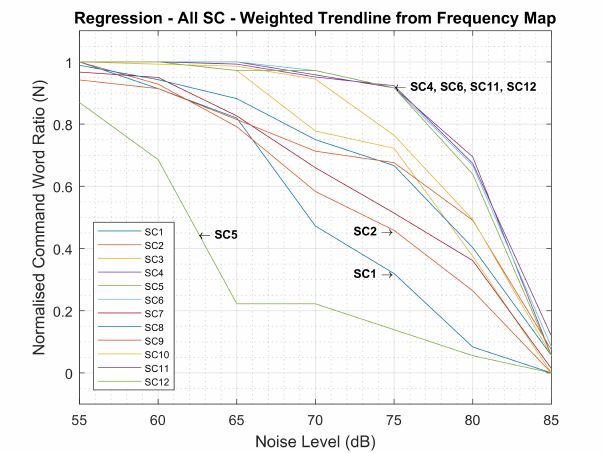
Figure 7. Comparing all SC